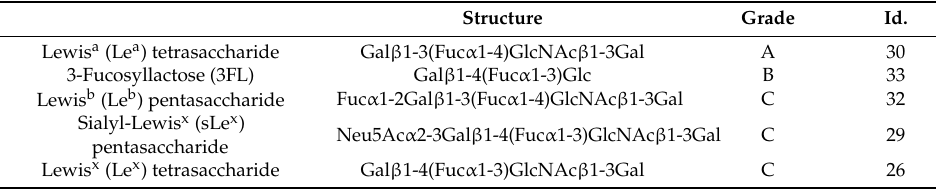
Figure 3. Overview of the screening of the 156 glycans. 36 competed for the interaction of LecB with the immobilized fucocluster F1.